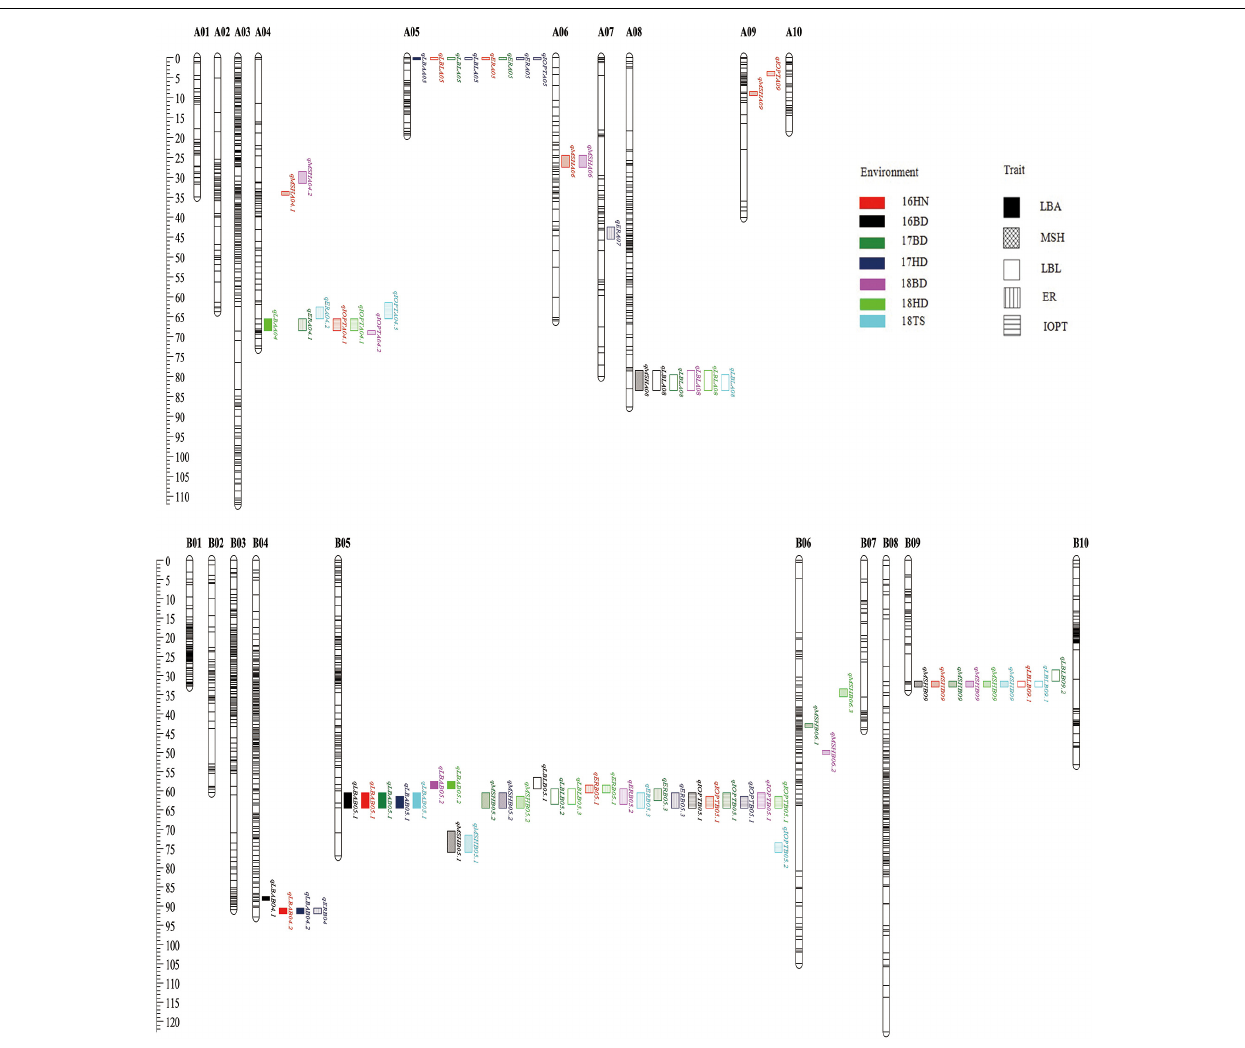
FIGURE 5 | The distribution of QTLs for growth habit-related traits on the genetic linkage